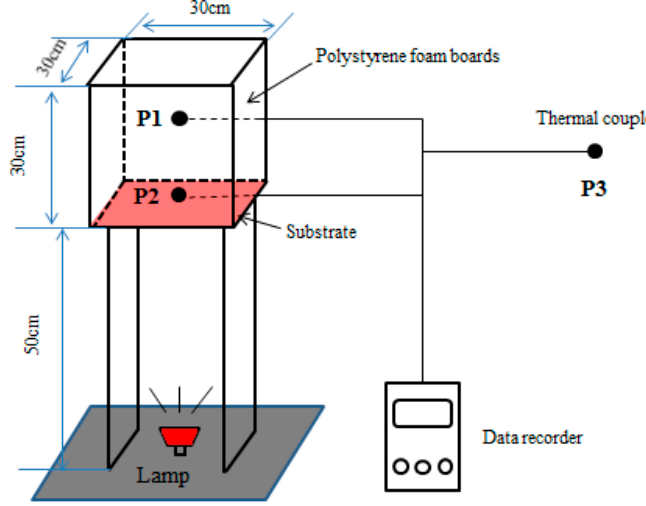
Figure 2. Schematic diagram for testing the heat insulating properties of coatings.